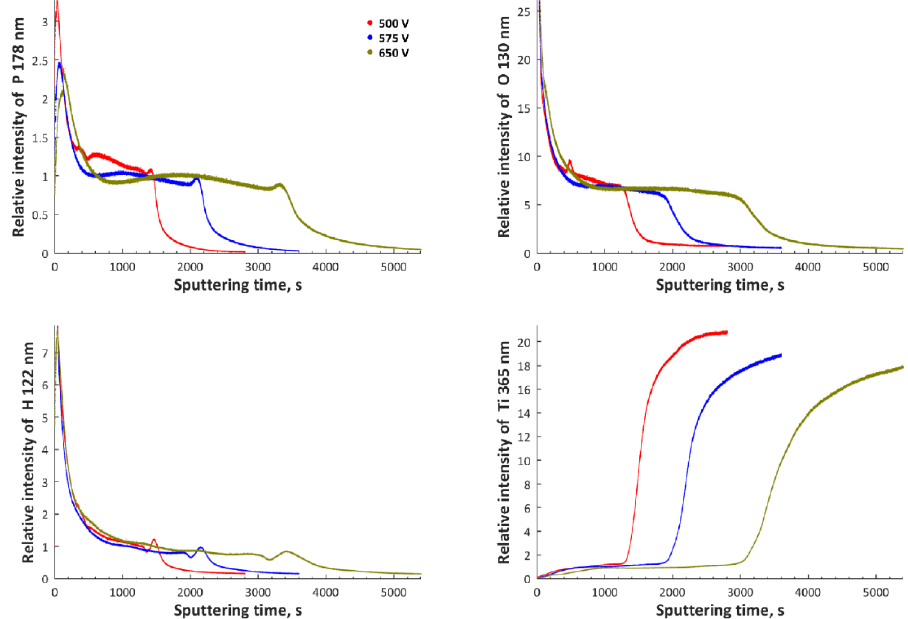
Figure 5. GDEOS signals of phosphorus (P), oxygen (O), hydrogen (H) and titanium (Ti) of coatings formed on CP Titanium Grade 2 after PEO process at voltages 500 V DC , 575 V DC , 650 V DC , in 1 L of 85% H 3 PO 4 with the additions of 125 g Ca(NO 3 ) 2 ·4H 2 O, 125 g Mg(NO 3 ) 2 ∙6H 2 O, 125 g Zn(NO 3 ) 2 ∙6H 2 O, and 125 g Cu(NO 3 ) 2 ∙3H 2 O.